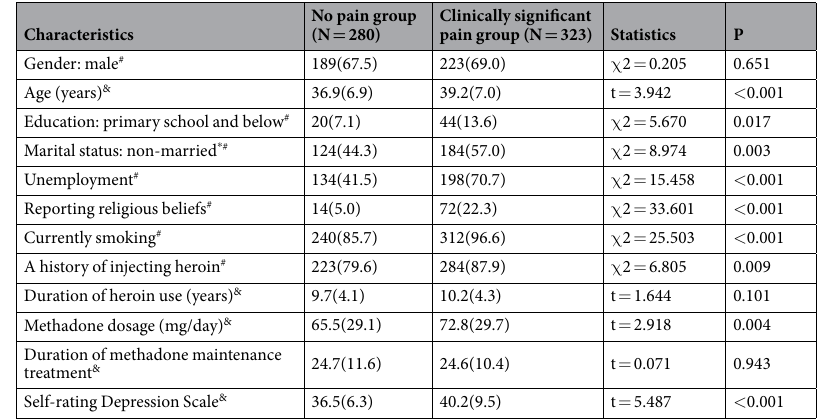
Table 1. Comparison of socio-demographic and clinical characteristics between methadone patients with and without pain. * “Non-married” includes never-married, remarried, cohabitating, separated/divorced, and widowed. # Categorical variables are expressed as number of cases (%). & Continuous variables are expressed as mean (standard